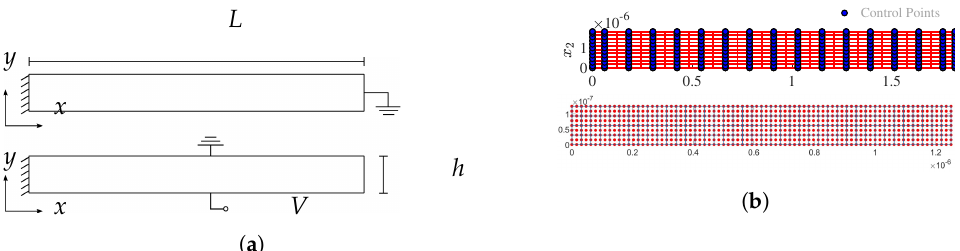
Figure 6. ( a ) Schematic of a hollow cylinder. Two different types of electrical boundary condition are imposed. The upper figure describes Type-1 boundary where zero electric potential is imposed on the right edge. Type-2 boundary is demonstrated in the lower figure where zero electric potential is applied on the top edge and an unknown equipotential (due to the electrode) on the bottom edge. ( b ) IGA discretization (top) and mixed FEM discretization (bottom). Table 5. Material parameters for the problem depicted in